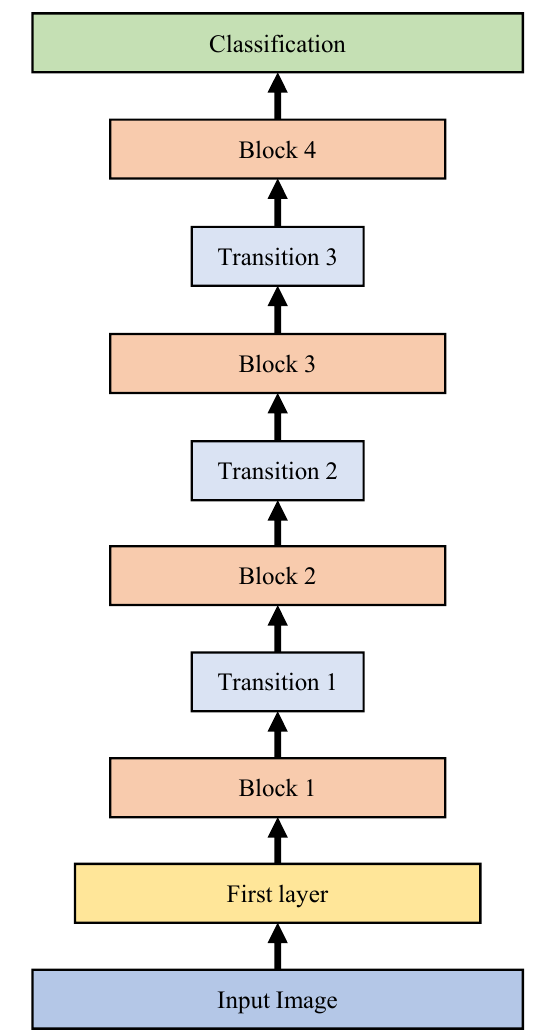
Figure 5. The block diagram of the modified DenseNet-201